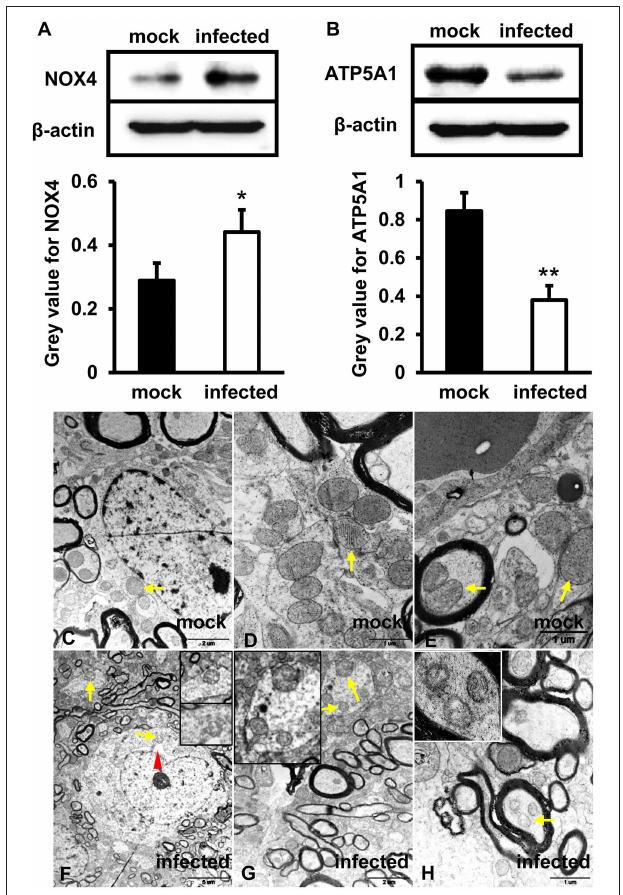
FIGURE 1 | Mitochondrial dysfunction was related to an increased level of NOX4 and decreased expression of ATP5A1 in HEV infected brain tissues. (A,B) in vitro , HBMVECs were inoculated with 300 MOI HEV for 48h for western blot, and HEV-negative homogenate served as control. Data showed that expression of NOX4 in HBMVECs treated with HEV for 48h was significantly increased compared with mock group ( * p < 0.05). Meanwhile, ATP5A1 was detected significantly attenuated in HEV inoculated cells ( ** p < 0.01). (C-H) In vivo , brain and spinal cord tissues that detected for HEV-RNA positive were selected for ultrastructural study. (C–E) Mitochondria were observed with clear cristae folded by the inner membrane in brain tissue of mock group. (F–H) Mitochondria with loss of cristae were found in tissues of HEV infected animals (arrows). The rough endoplasmic reticulum of neuron cells was also observed with mild distended cisternal space in HEV infected tissues (arrowhead). For western blot, gray value was analyzed with ImageJ to quantitatively analyze the expression levels of targeted proteins according to the level of exposure gray (resolution). Data were finally normalized to the expression of anti- β -actin.